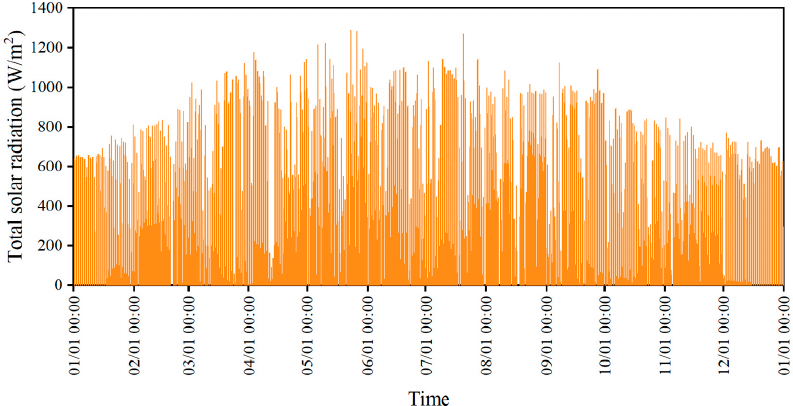
Figure 4. The annual total solar radiation of Aba County. Table 1. Optimal size of the T-wall structure [21].